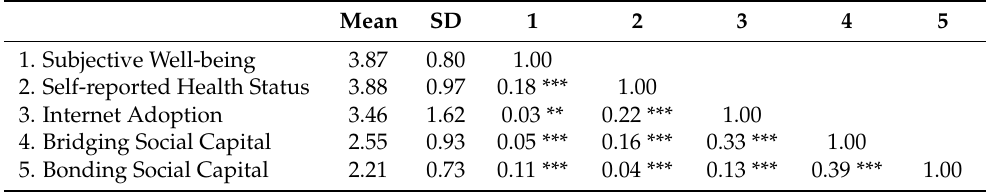
Table 3. Descriptive analysis and correlational coefficients of studied